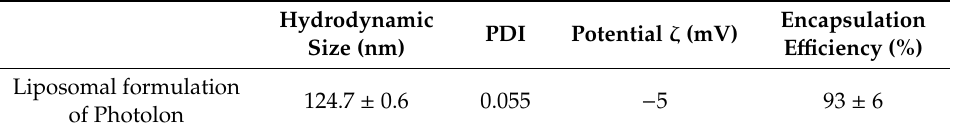
Table 1. Summary of physical characterization of liposomal formulation of PVP-conjugated chlorin e6 (Photolon).